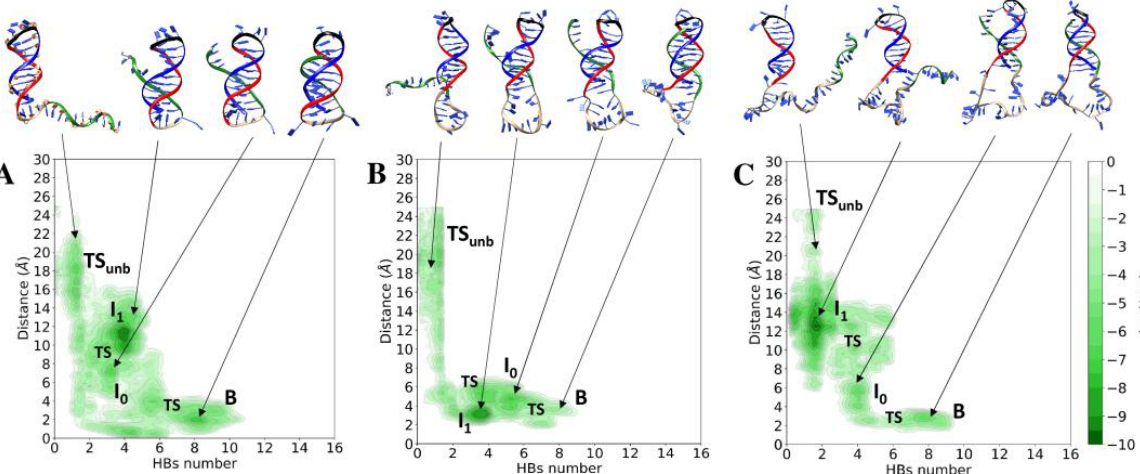
Figure 3. Iso-energetic contour of the free energy surface plotted as a function of the HB number established between the TFO and the DH, and of the distance between their centers of mass for the TETRA5 ( A ), TETRA15 ( B ) and TETRA25 ( C ) systems. The upper structures are the representative configurations of the most populated clusters of the Bound (B), Intermediate (I 0 and I 1 ) and Transition (TS unb ) states, extracted from the trajectories. The color scheme follows that described in Figure 1.